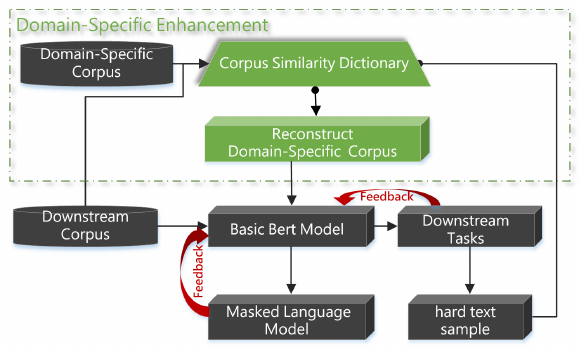
Figure 2. A Joint Pre-Training Method Based on Data